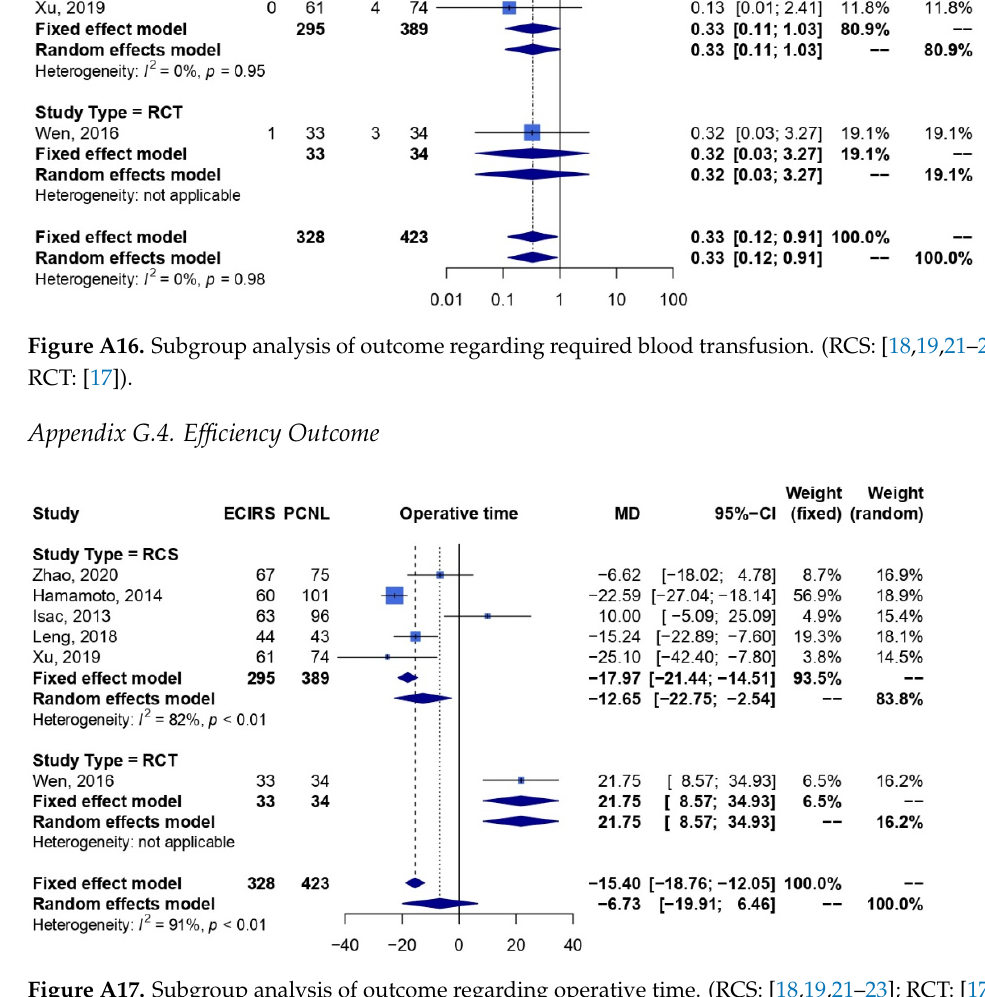
Figure A18. Subgroup analysis of outcome regarding hospital stay. (RCS: [18,19,21–23]; RCT: [17])